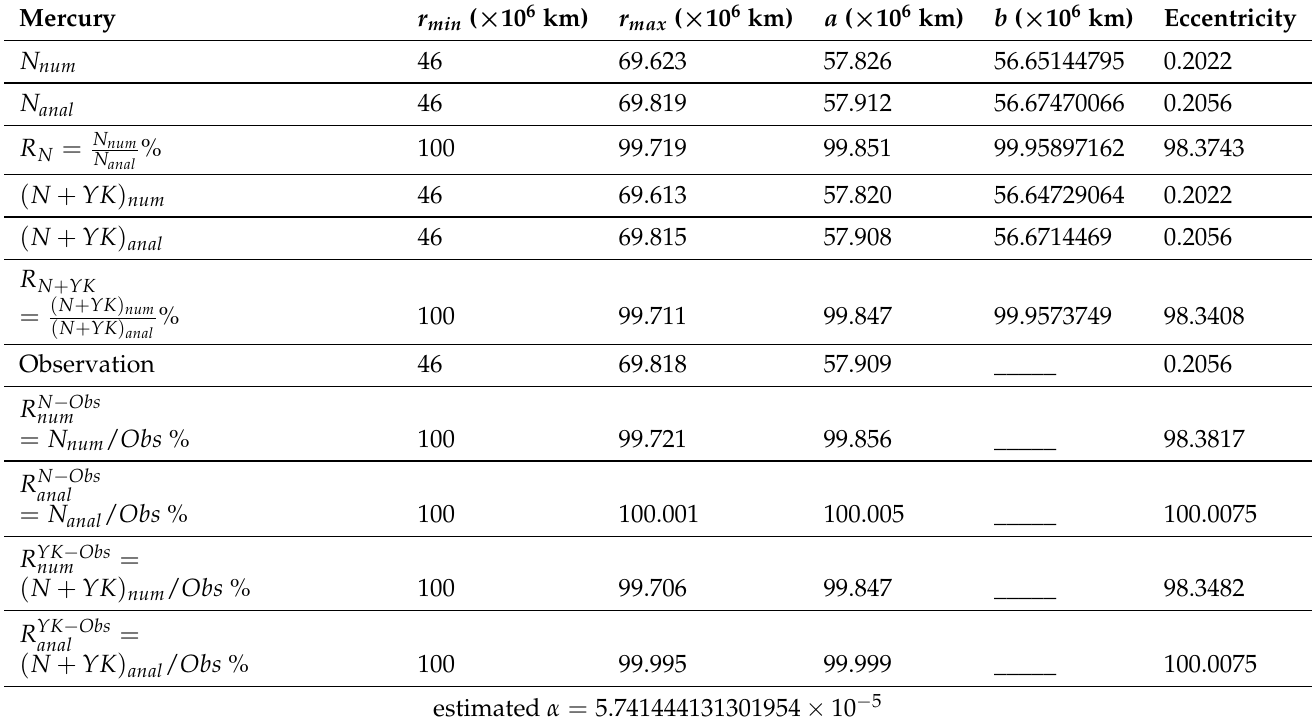
Table A2. The values of the calculated and observational astronomical parameters, for estimated α , of the planet Mercury, whose number of moons is 0.